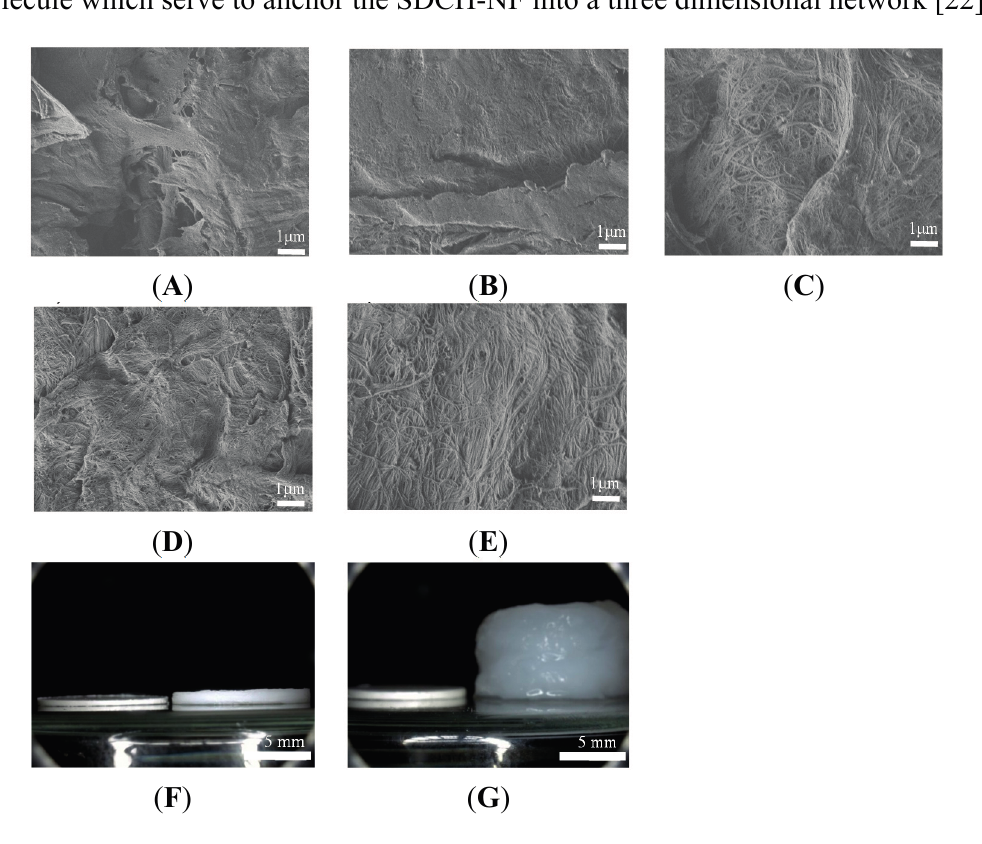
Figure 4. FE-SEM micrographs of surface of CH ( A ), SDCH-NF ( B , D ), SDCH-NF/HA tablet ( C , E ), before ( A – C ) and after ( D , E ) release study. Microscopic observations of SDCH-NF only ( left ) and SDCH-NF/HA ( right ) tablets before ( F ) and after ( G ) release